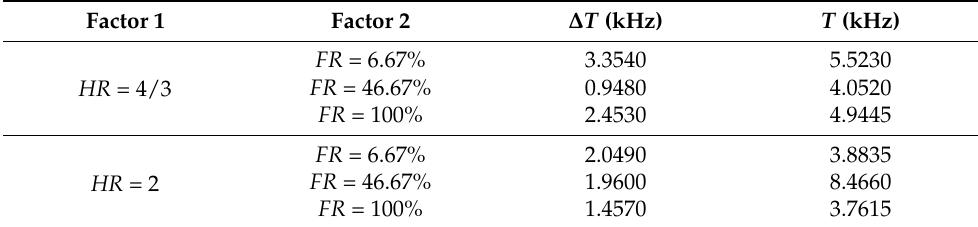
Figure 10. Low frequency band gaps with different parameter structures. ( a ) Low frequency band gap plots at different FR when HR = 4/3; ( b ) low frequency band gap plots at different FR when HR = 2. Table 2. The width and median frequency of the band gap.